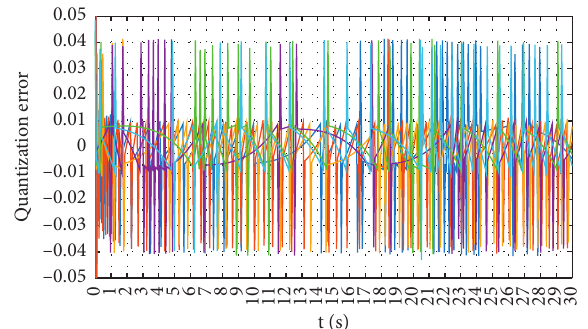
( t )( i � 1 , 2 , .. . , 6 ) . Figure 6: Nonuniform quantization error e qi